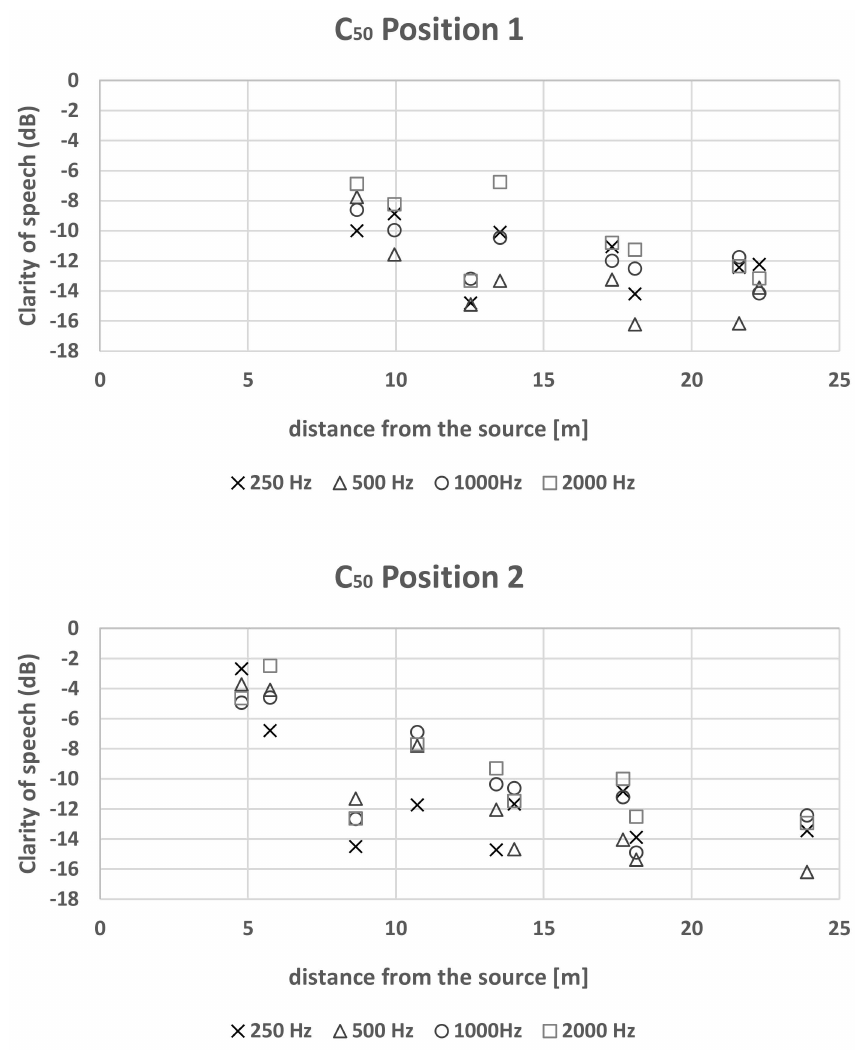
Figure 13. C 50 vs. distance from the source position 1 ( top ) and 2 ( bottom